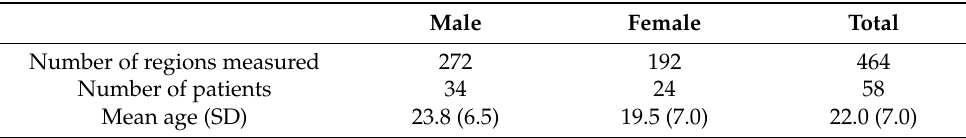
Table 1. Characteristics of the samples. Male Female Total Number of regions measured 272 192 464 Number of